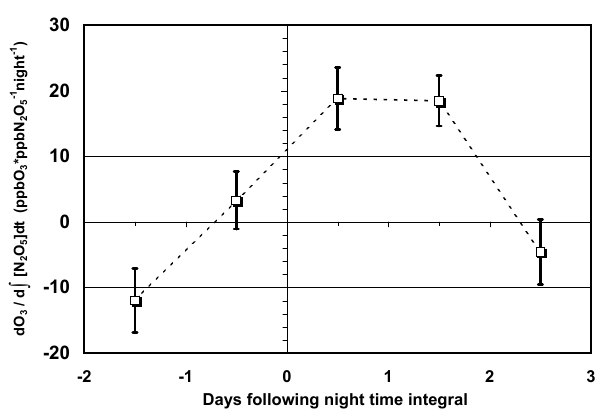
Fig. 11. Average response of peak hourly average ozone at monitor- ing stations in the valley to overnight integral of N 2 O 5 with respect to time in the marine air of the Strait, for days following a nighttime integral. Day + 0.5 corresponds to the day immediately following a nighttime measurement. The analysis includes only nights in which a significant observable sea breeze was observed the next day.